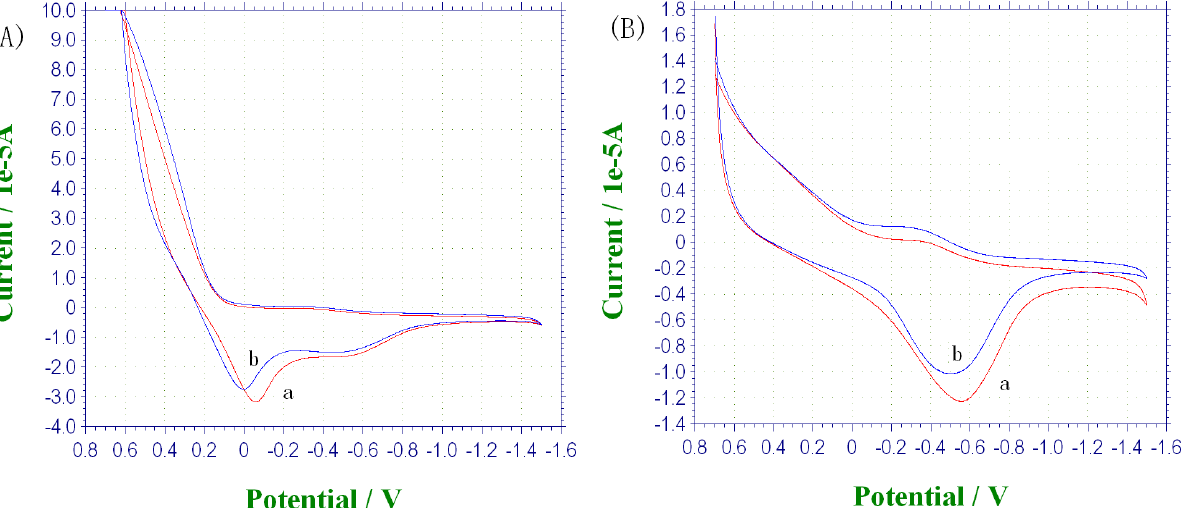
Figure 7. Cyclic voltammetry of the electrodes in the PBS solution (pH7.0). (A) electrodes modified with PPy/HRP/ ferrocyanide (B) electrodes modified with PPy/HRP. (curve a-- with 1 mMH